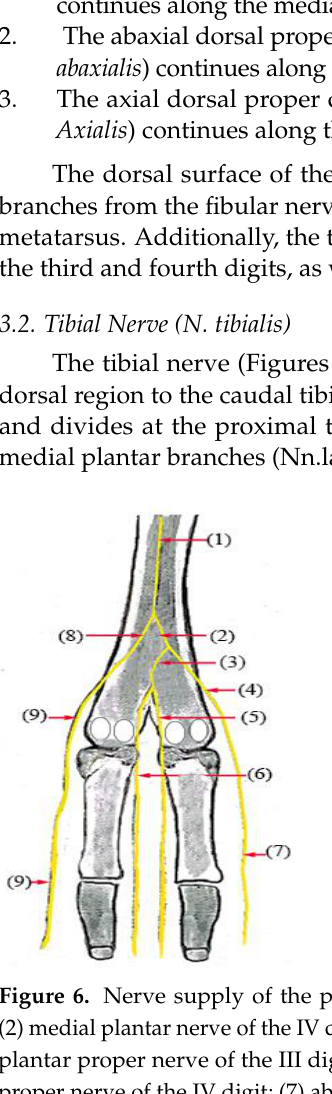
Figure 7. Nerve supply of the plantar surface of the phalanx in camels: (1) medial plantar nerve (common plantar digital nerve of the III digit); (2) interdigit branch of medial plantar nerve; (3) axial plantar proper digital nerve of the IV digit; (4) abaxial plantar proper digital nerve of the III digit.